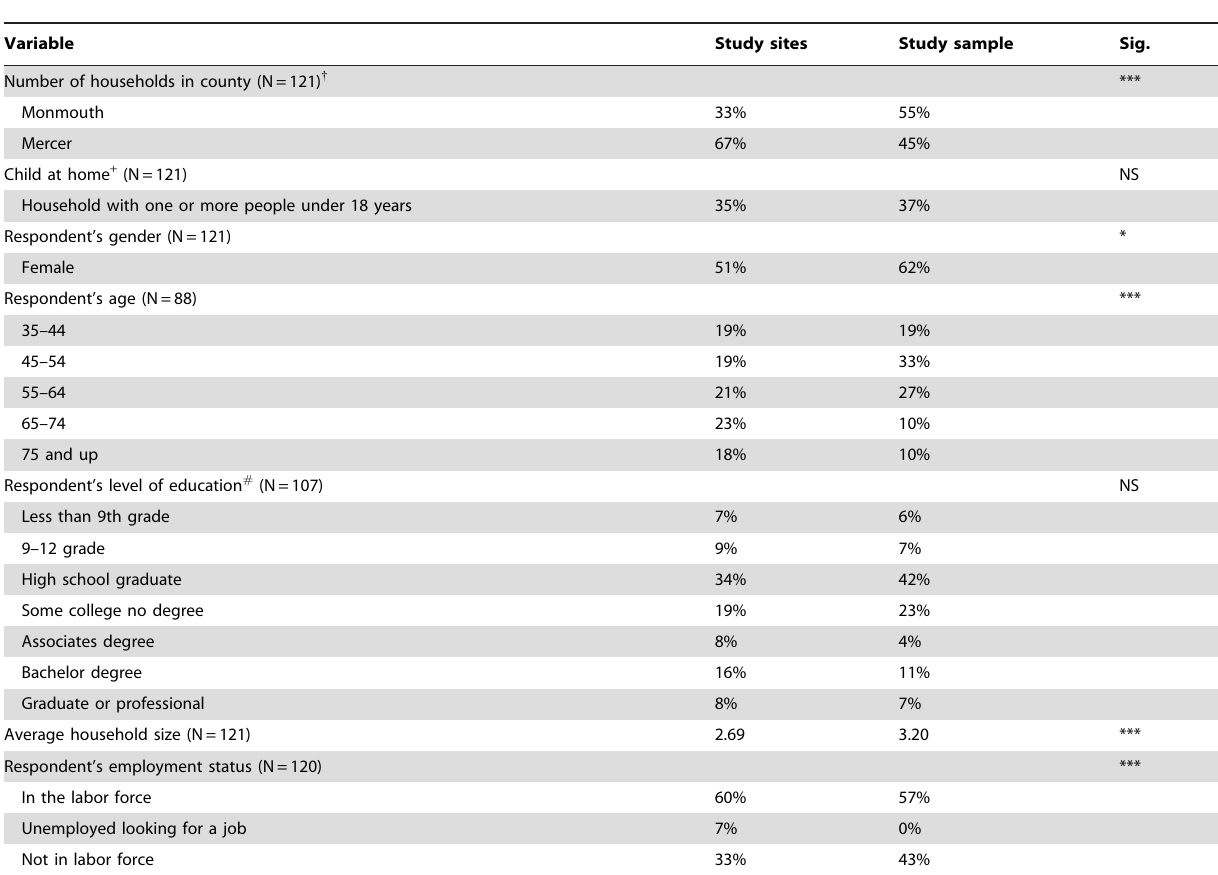
Table 1. Household characteristics of respondents compared to study sites and counties,